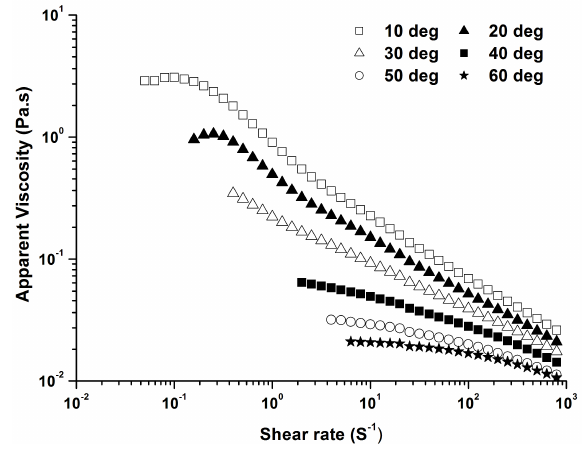
Figure 2. Effect of temperature on apparent viscosity of 1.0% PLAP.